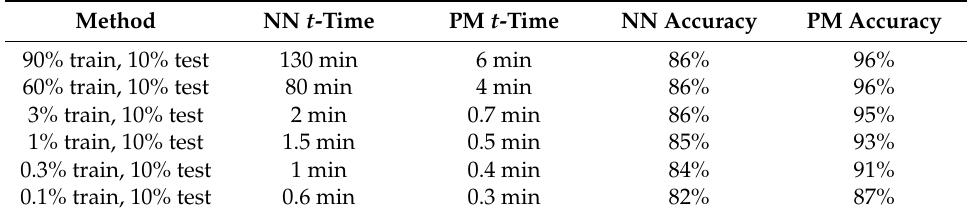
Table 1. E ffi ciency comparison of the proposed method (PM) with neural network